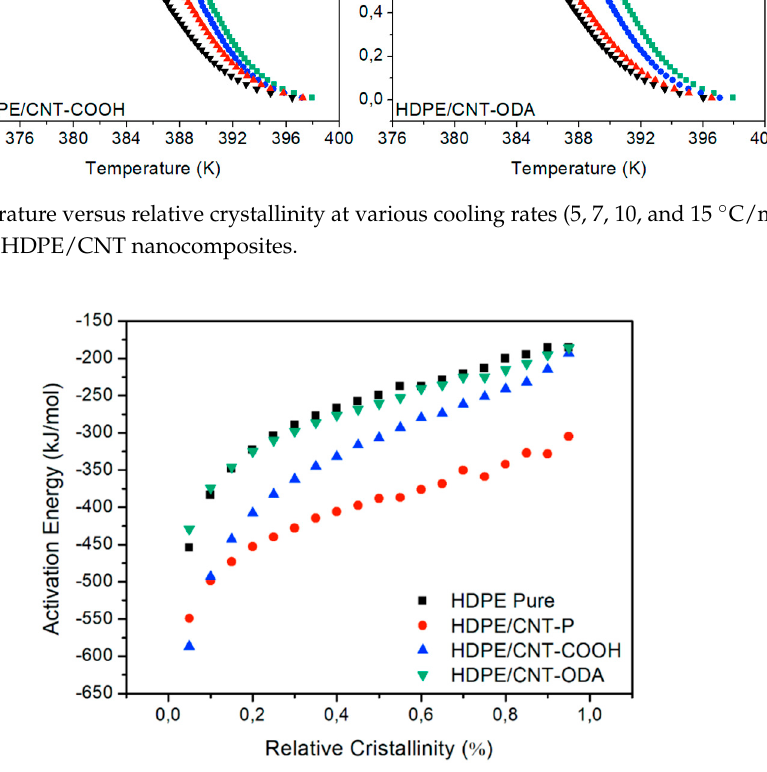
Figure 4. Activation energy versus relative crystallinity at various cooling rates (5, 7, 10, and 15 °C/min) for pure HDPE and HDPE/CNT nanocomposites.